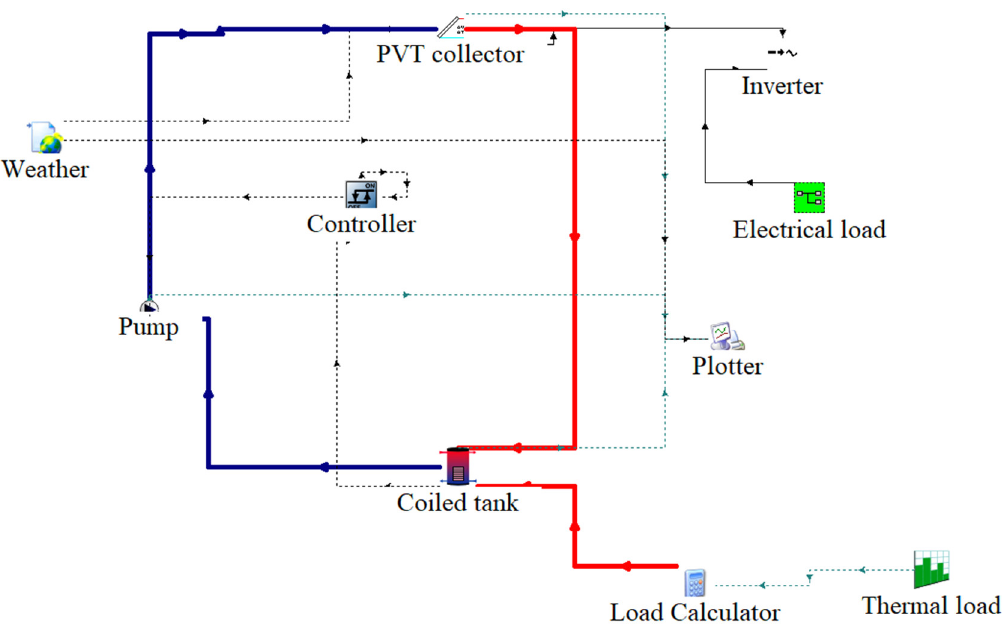
Figure 6. TRNSYS System.